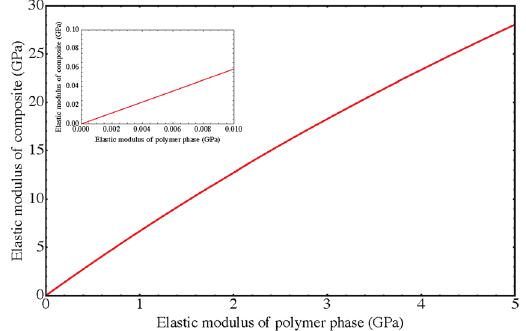
Figure 4. Elastic modulus of the nanocomposite E Comp as a function of the elastic modulus of the polymer phase E P calculated for a primitive lattice of cubic nanograins of size g = 8.8 nm and thickness of polymer matrix phase p = 1.8 nm. To achieve composite moduli on the order of 10–20 GPa the modulus of the polymer phase must be on the order of 2–4 GPa. The inset shows the modulus range around 1 MPa for the polymer, which was measured in the rheological experiments and leads to composite moduli which are 3 orders of magnitude lower than the measured